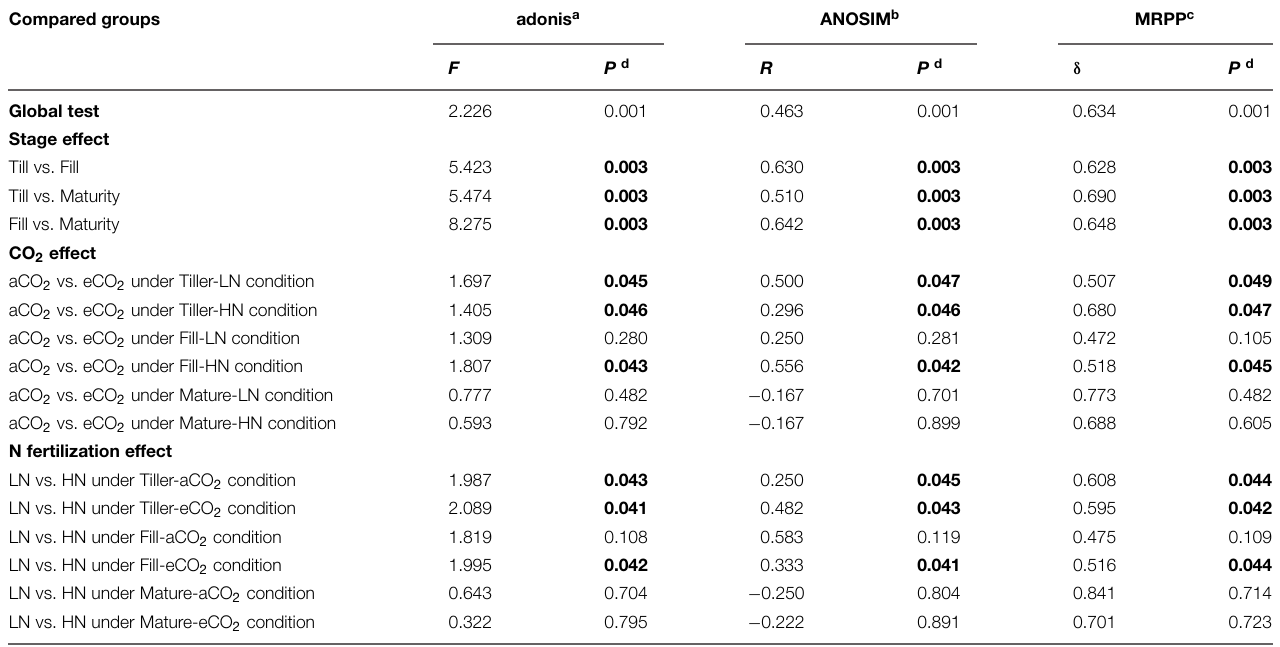
TABLE 1 | Significance tests using three statistical approaches to assess the effects of growth stages, CO 2 , and N fertilization on the overall microbial community structure. Compared groups